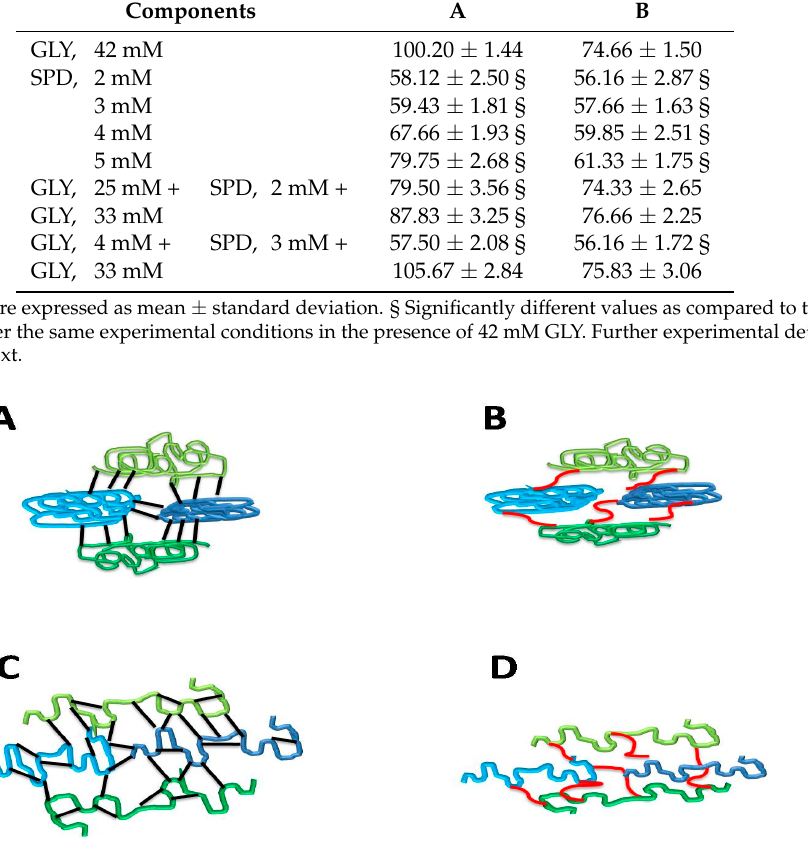
Figure 6. Proposed model of hydrogen bond GLY (black bar in A , C ) and ionic SPD (red bar in B , D ) interactions with BV proteins at pH 8.0 following FFS treatment for 30 min at either 25 °C ( A , B , native proteins) or 80 °C ( C , D , denatured proteins). The different kind of binding of GLY (hydrogen) and SPD (ionic) to BV proteins is proposed to be responsible for the different film thickness (minor thickness = major compactness for PA-containing film).